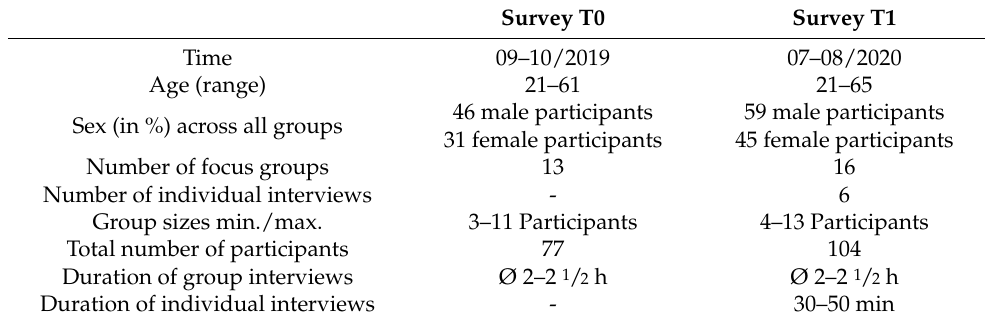
Table 1. A description of the samples